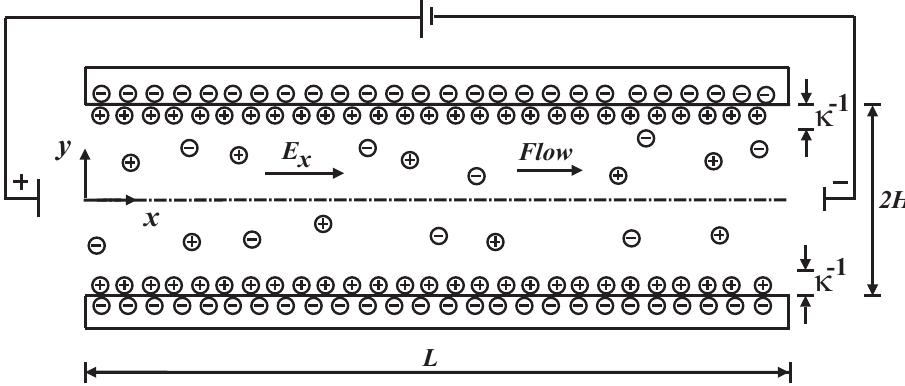
Figure 1. Schematic sketch of electroosmotic flow between two parallel flat